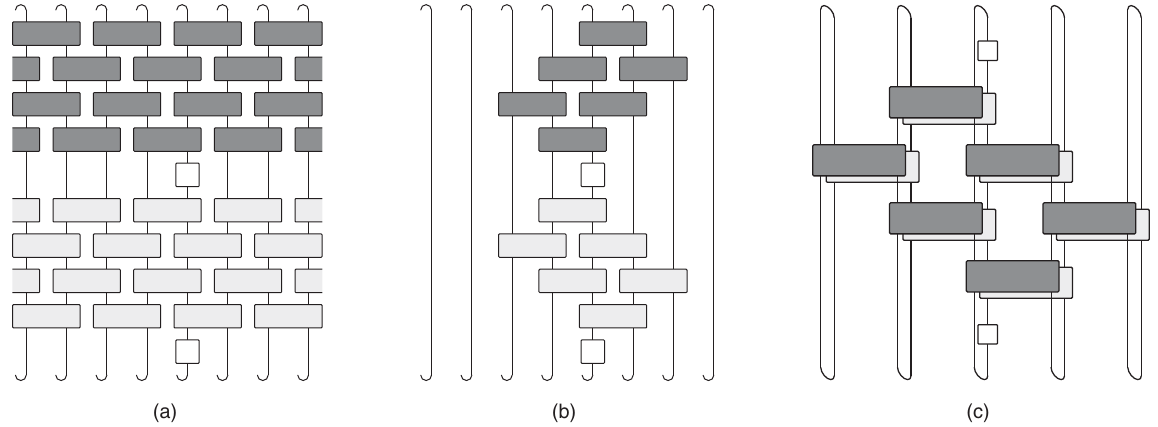
FIG. 2. Illustration of Tr ½ O ð t Þ O ð 0 Þ(cid:2) for t ¼ 2 . U ’ s and U † ’ s are represented by rectangles, respectively, shaded in light and dark gray. The local operator O x is represented by a square. The curled lines at the top and bottom edge indicate closed loops which denote the trace operation. (a) Initial expression. (b) After cancellation of pairs of U with U † wherever possible. The boundaries of the regions within which U ’ s and U † ’ s remain form light cones with a velocity v ¼ 2 set by the construction of the model. (c) Illustration of Tr ½ O ð t Þ O ð 0 Þ(cid:2) for t ¼ 2 formed by folding Fig. 2 (right) so that timelines run upward for W and downward for W †